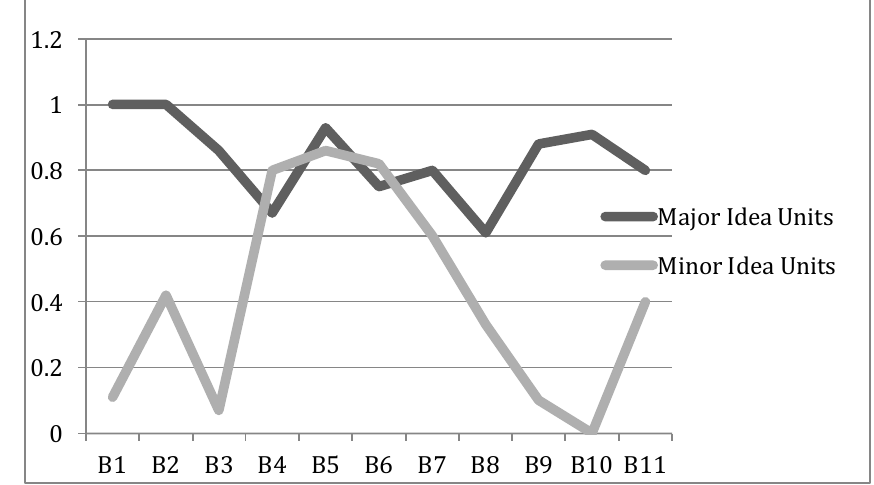
Frequency of major and minor idea units over time for